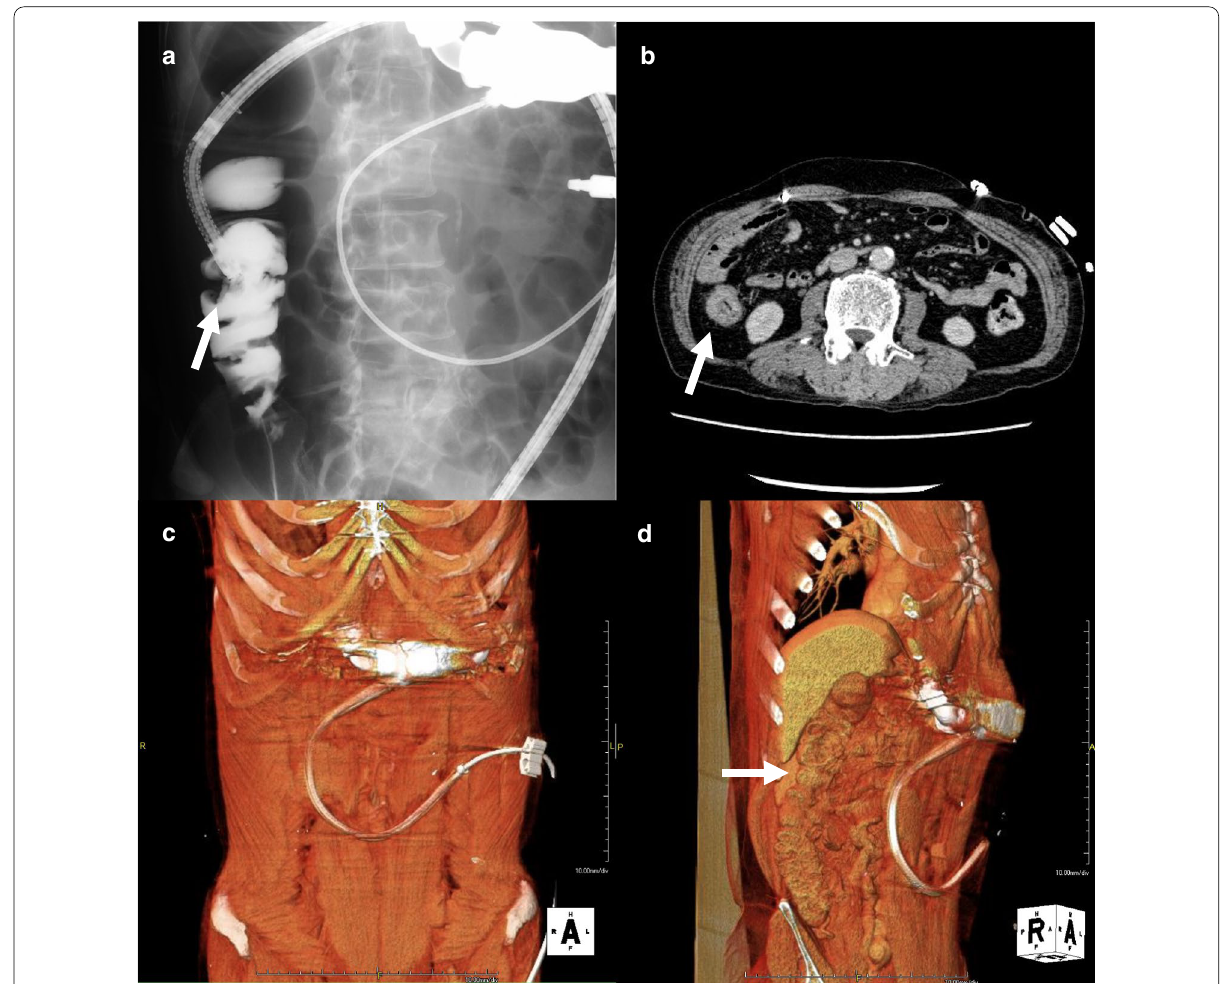
Fig. 1 The positional relationship between the tumor and the driveline by X-ray ( a ) and CT images ( b ). The tumor (arrow) is away from driveline. c , d The positional relationship between the tumor (arrow) and the driveline by 3D CT